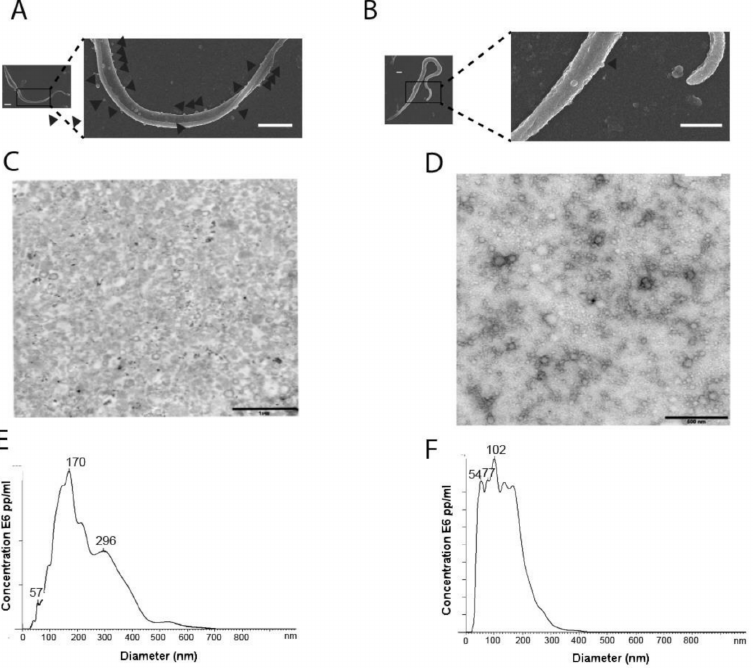
Figure 1. Purification of the extracellular vesicles (EVs) of epimastigotes (E) and EVs of tissue-culture cell-derived trypomastigotes (TCT) of T. cruzi (Pan4 strain, DTU I). Scanning electron microscopy (SEM) of E ( A ) and TCT ( B ) employed in this study (scale bar: 1 µ m). ( C ) Transmission electron microscopy (TEM) of purified EVs of E (scale bar: 1 µ m). ( D ) TEM of purified EVs of TCT (scale bar: 500 nm). ( E ) Nanoparticle tracking analysis (NTA) size distribution of purified EVs of E. ( F ) NTA size distribution of purified EVs of TCT. Representative figures and graphs of 7 different replicates are